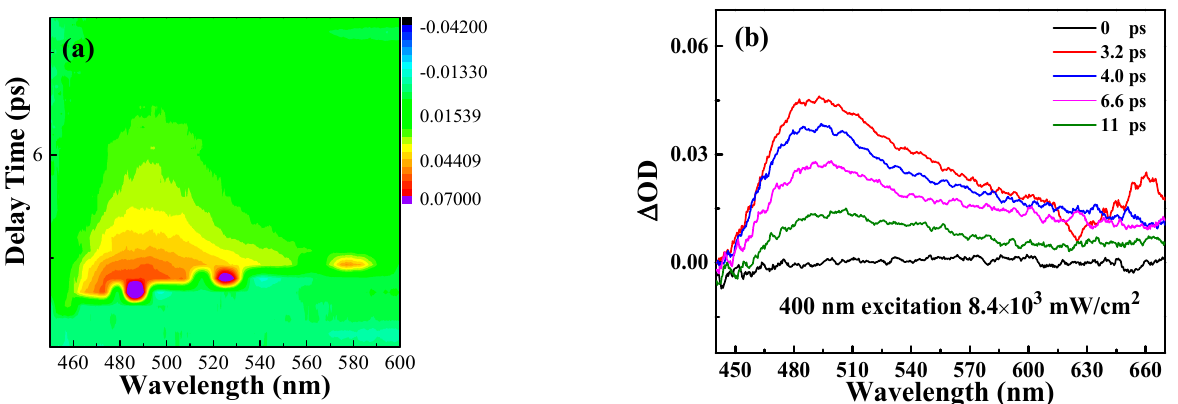
Figure 4. Carrier dynamics (at 400 nm pump) curves for Ag@V 2 C. ( a ) Two-dimensional (2D) mapping of transient absorption spectra pumped at 400 nm with a fluence of 8.4 × 10 3 mW/cm 2 , ( b ) Time and wavelength resolved transient absorption data of Ag@V 2 C.